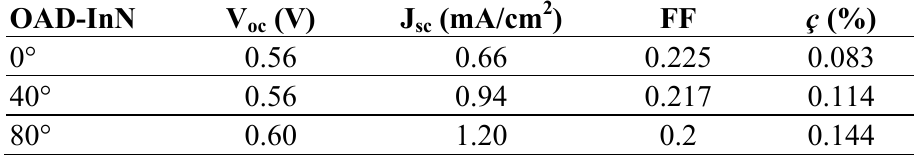
Table 1. The parameters of solar cells with various OAD-InN